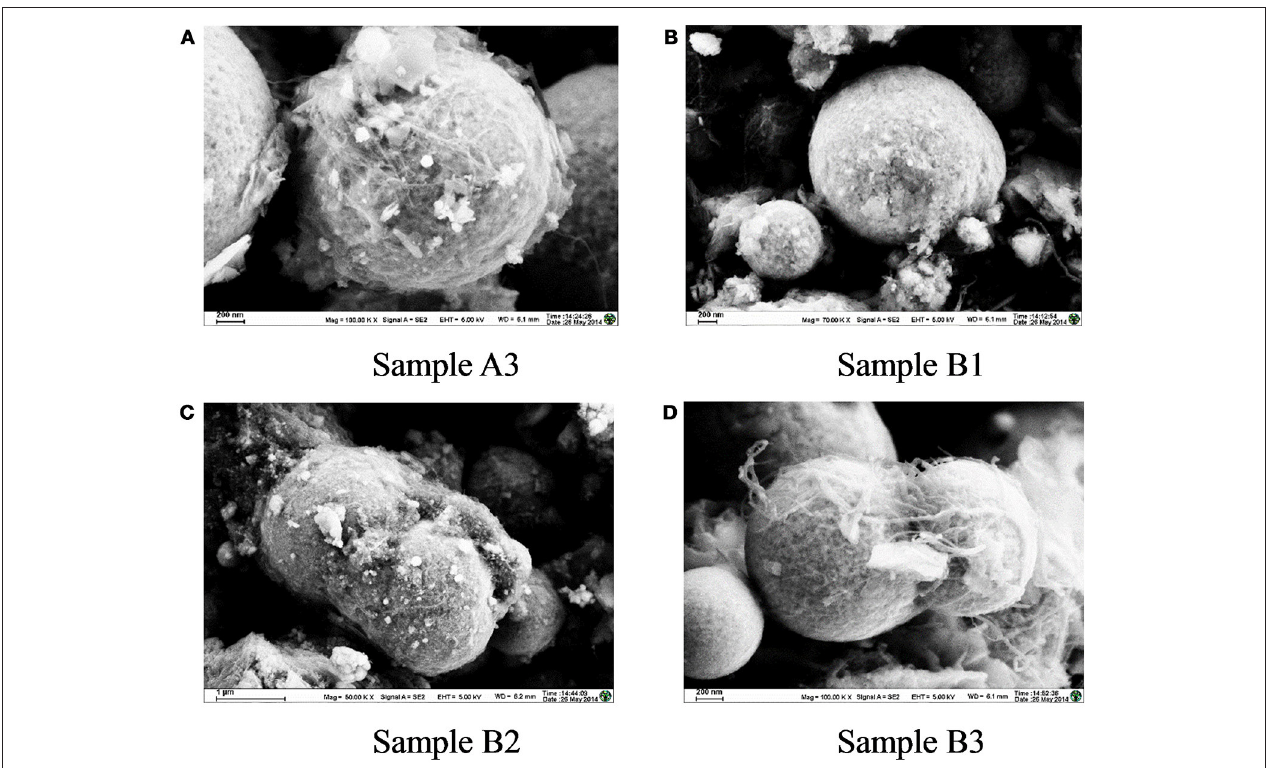
FIGURE 6 | The electron micrographs of composite particles with different dosages of MWNTs.